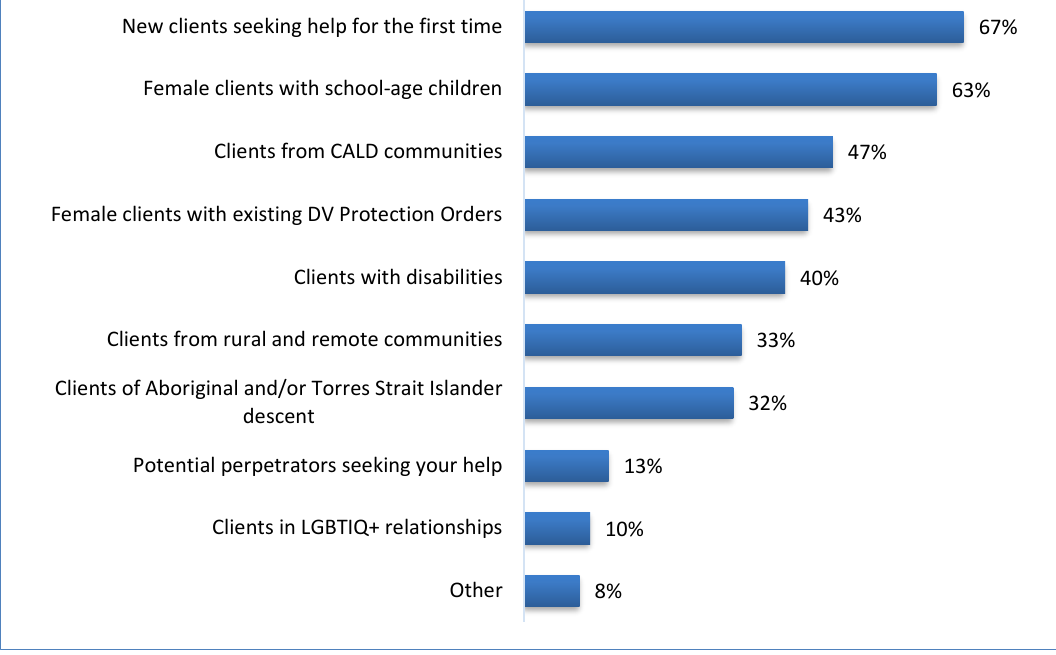
Almost 16% of service providers spoke about their perceived increased risk of violence and exclusion to vulnerable persons they were supporting. Children, older people, homeless people, ethnically diverse populations, those with a disability or mental illness, and women living in domestic violence situations were all identified in reports of negative impacts during the pandemic. Accessing support was identified as the biggest challenge for vulnerable populations, as the service system, which had been set up to accommodate their need to ‘drop in’ , had been disrupted. The service delivery restrictions have also decreased the visibility of accessing a service, which could also deter people from contacting or place them at greater risk because of that